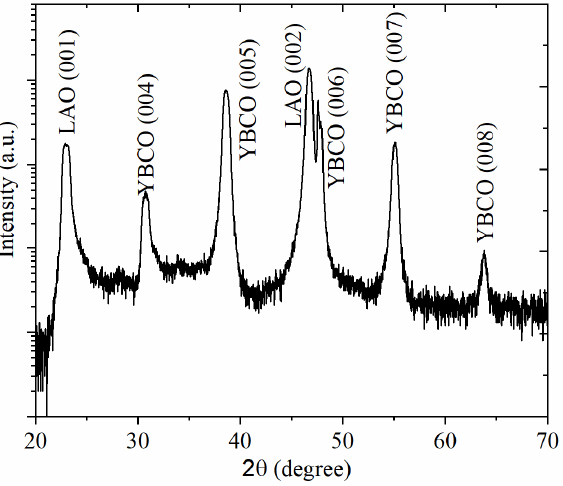
Figure 2. XRD pattern YBCO thin film grown on 15° vicinal cut LAO (001) substrate.